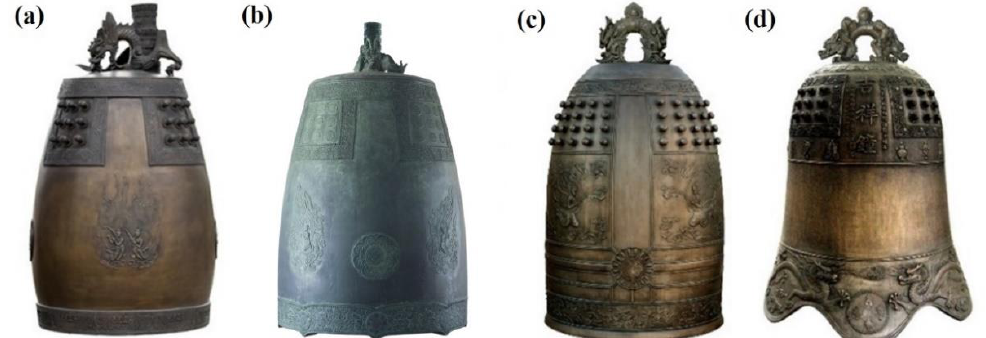
Figure 2. Important temple bells that evolved on Korean Peninsula. ( a ) Sangwonsa bell, ( b ) Songdok bell (Emille Bell), ( c ) Japanese bell, and ( d ) Chinese bell. Korean Buddhist ‘ Emille ’ Bell [26]. World